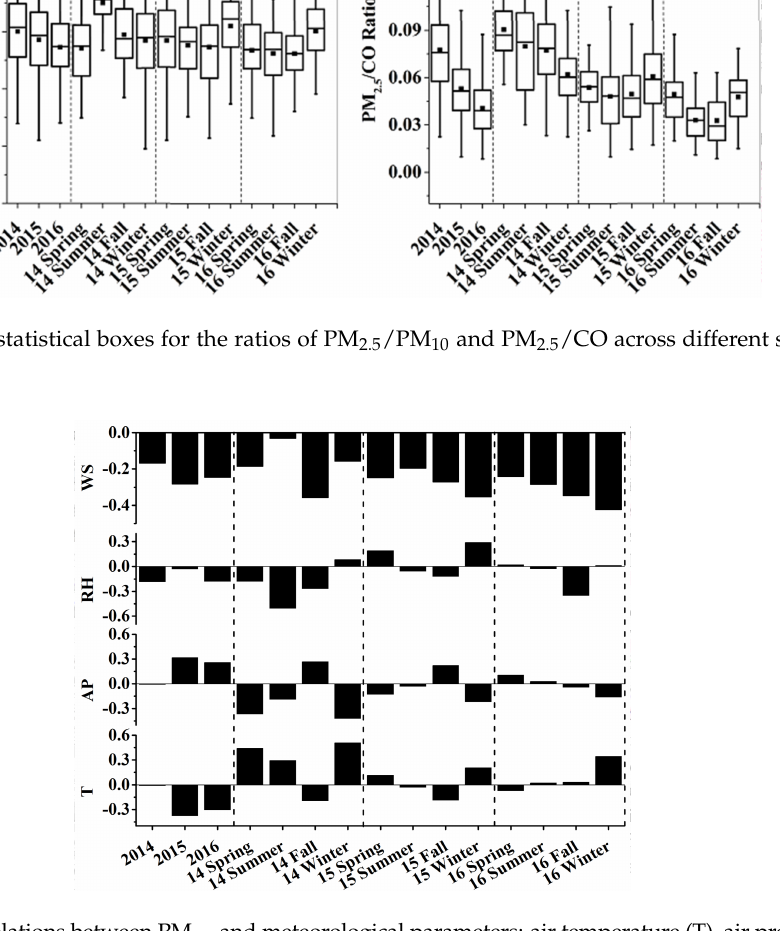
Figure 3. Correlations between PM 2.5 and meteorological parameters: air temperature (T), air pressure (AP), relative humidity (RH) and wind speed (WS) across different seasons in three